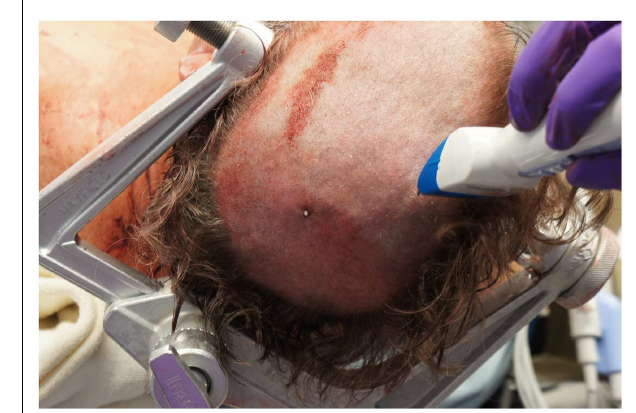
FIGURE 3 |View of the spear tip protruding through the skin overlying the left parietal bone .